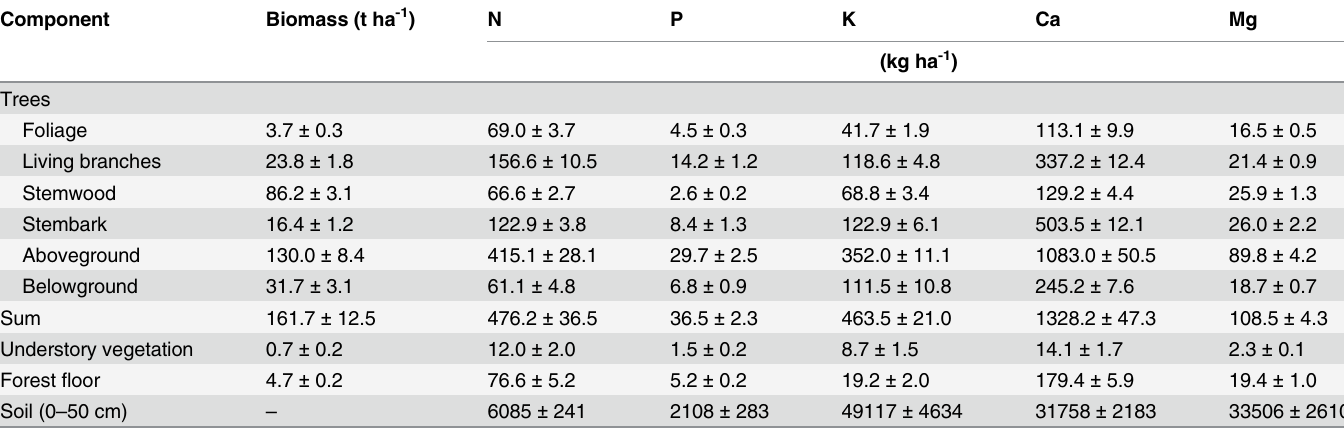
Table 3. Biomass and macronutrient contents in various plant components and soil in the 10-year-old P . deltoides plantation